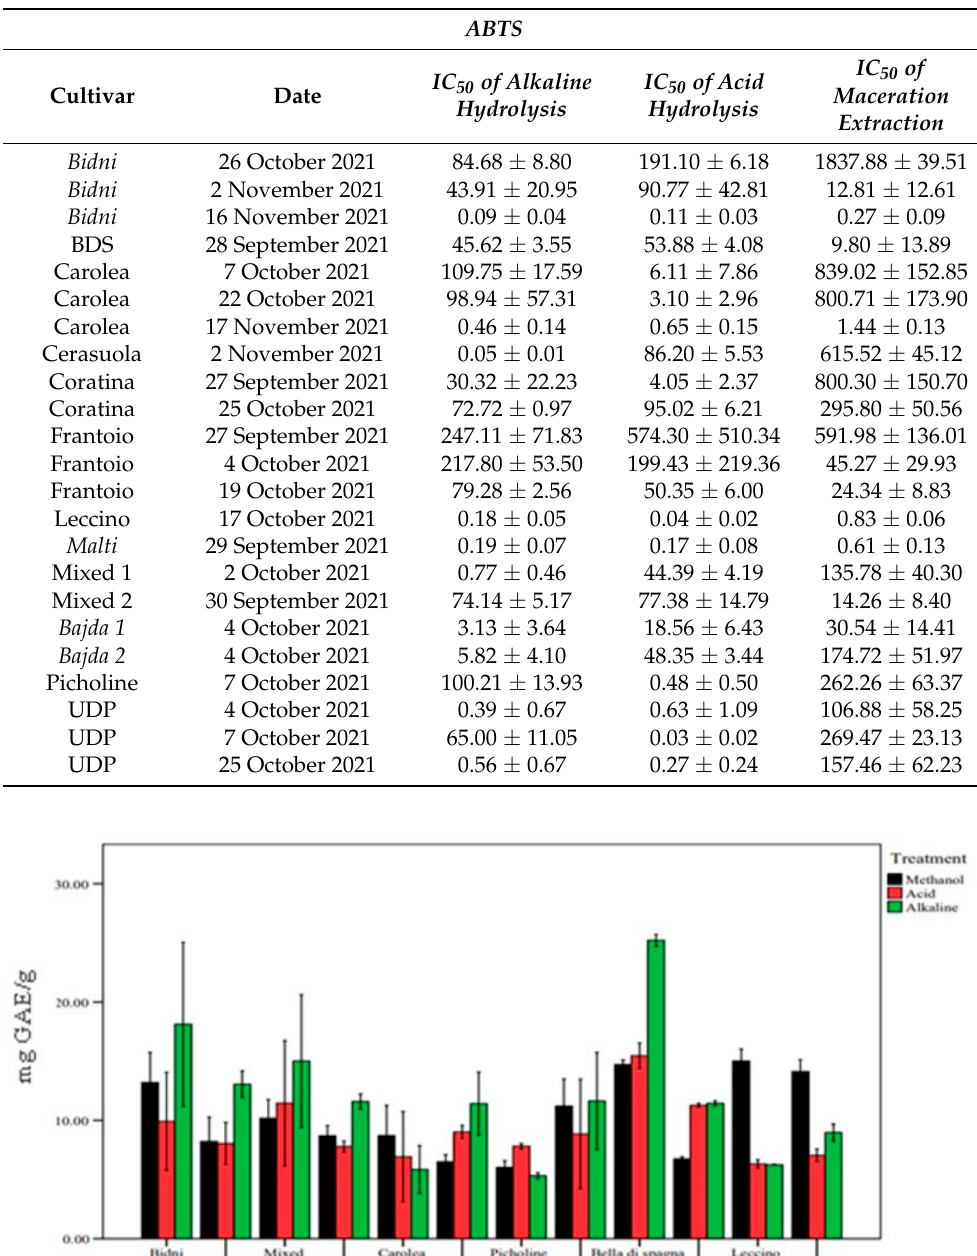
Table 2. IC 50 s of olive oil extracts for ABTS radical cation stabilization assays. (BDS—Bella di Spagna and UDP—Uovo di Piccione).